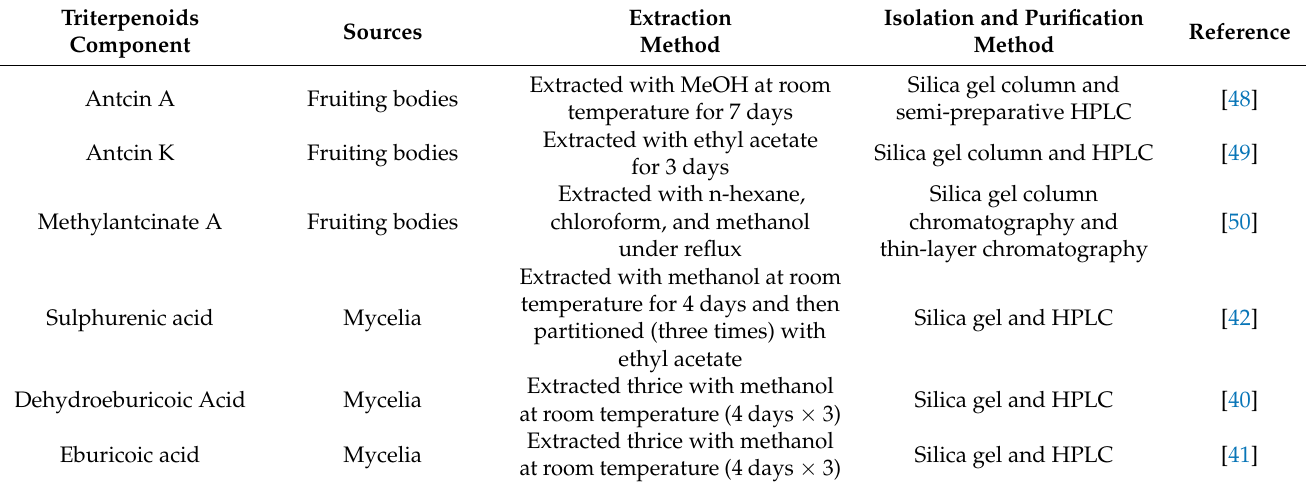
Table 2. Preparation procedures of triterpenoids from A. cinnamomea in recent